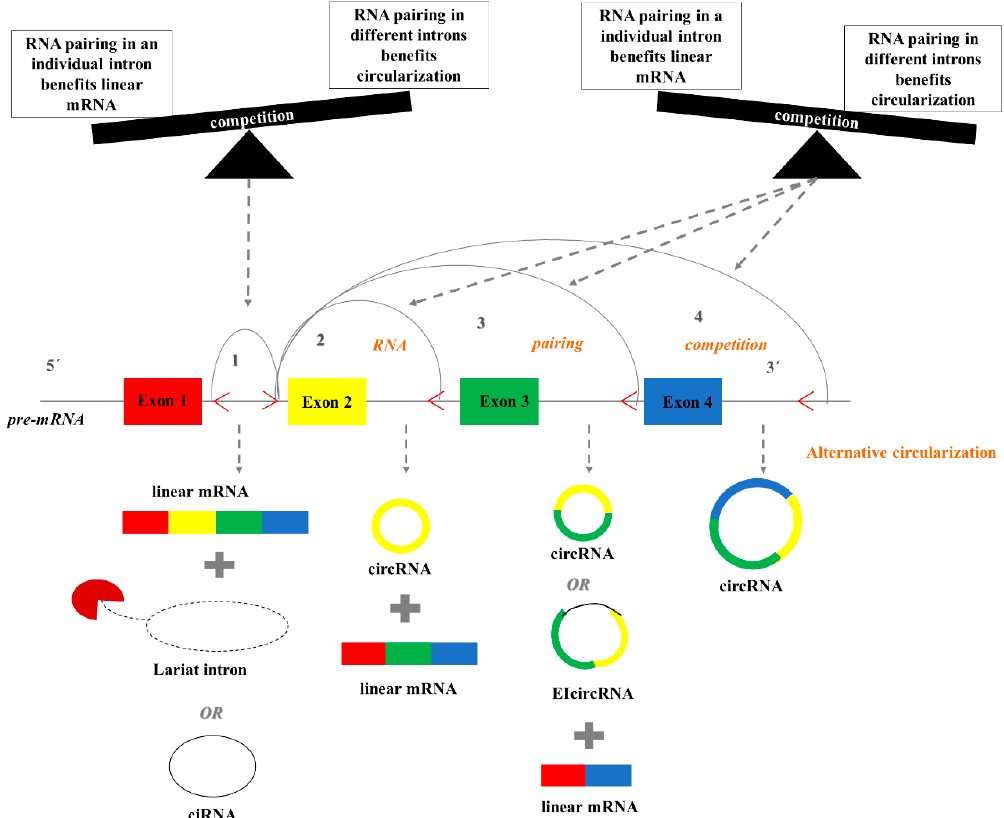
Figure 2. The model of alternative circularization. Multiple circRNAs and linear RNAs can be generated from a single gene locus, via RNA pairing competition. Complementary sequences within individual flanking introns favor linear mRNA formation, while complementary sequences in different flanking introns promote circularization. The competition between these reverse complementary sequences can lead to multiple circRNAs.